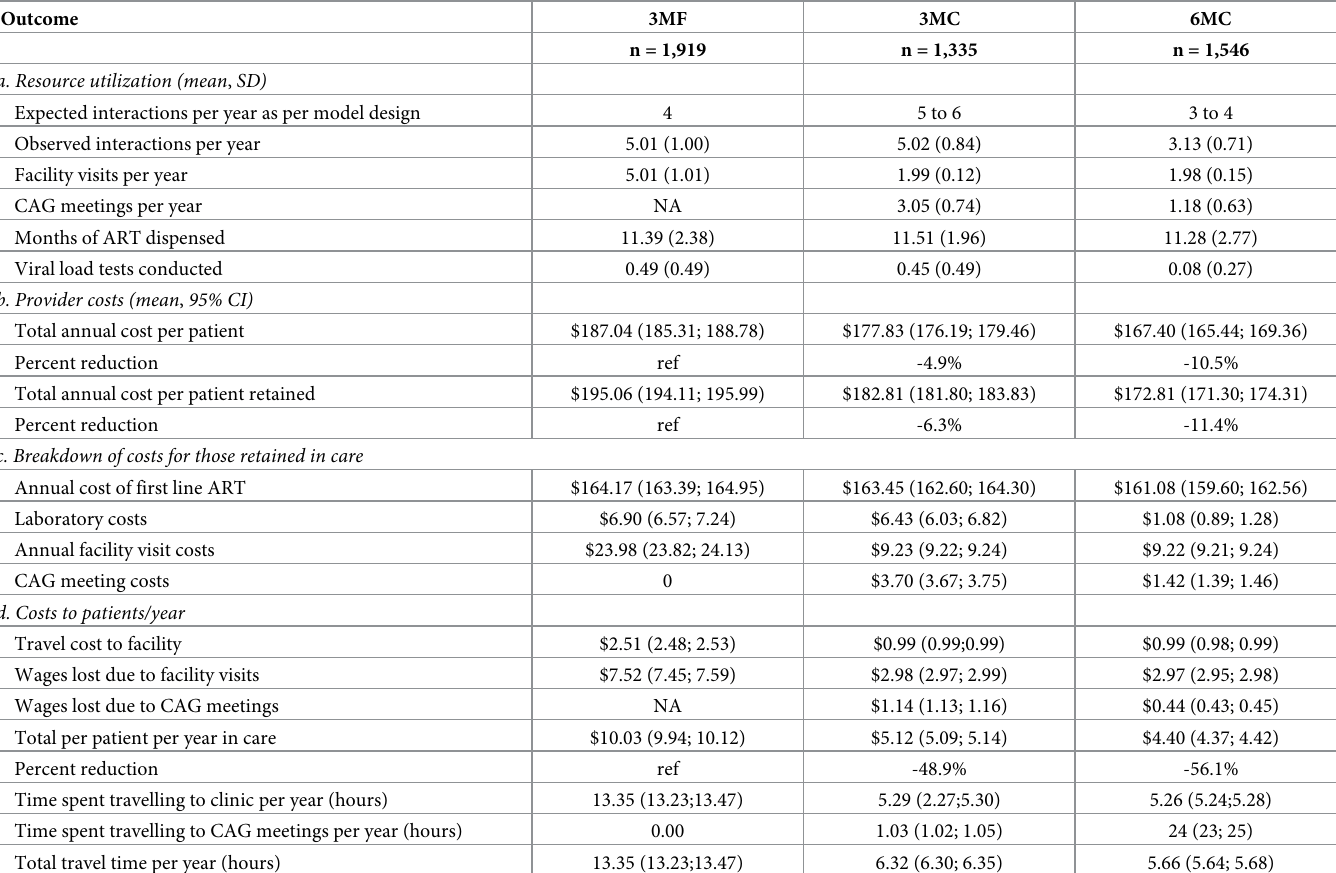
Table 1. Average resource utilization, cost per patient per year and per patient retained, and cost to